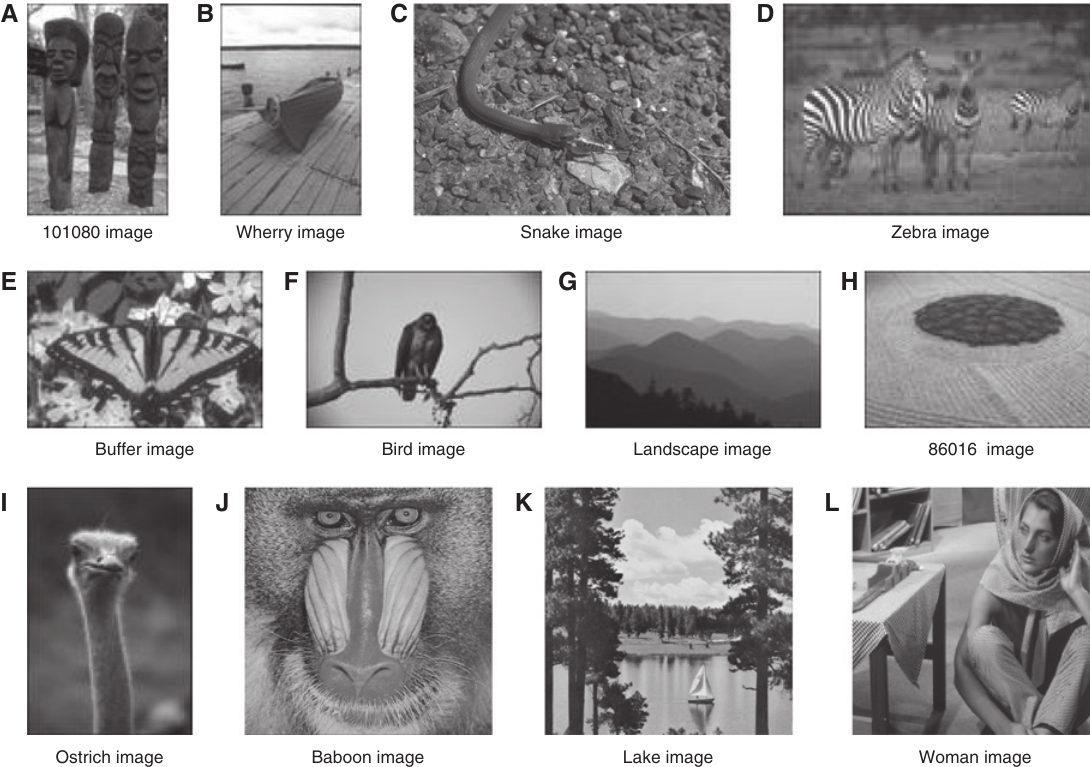
Figure 1: Real Images Used in the